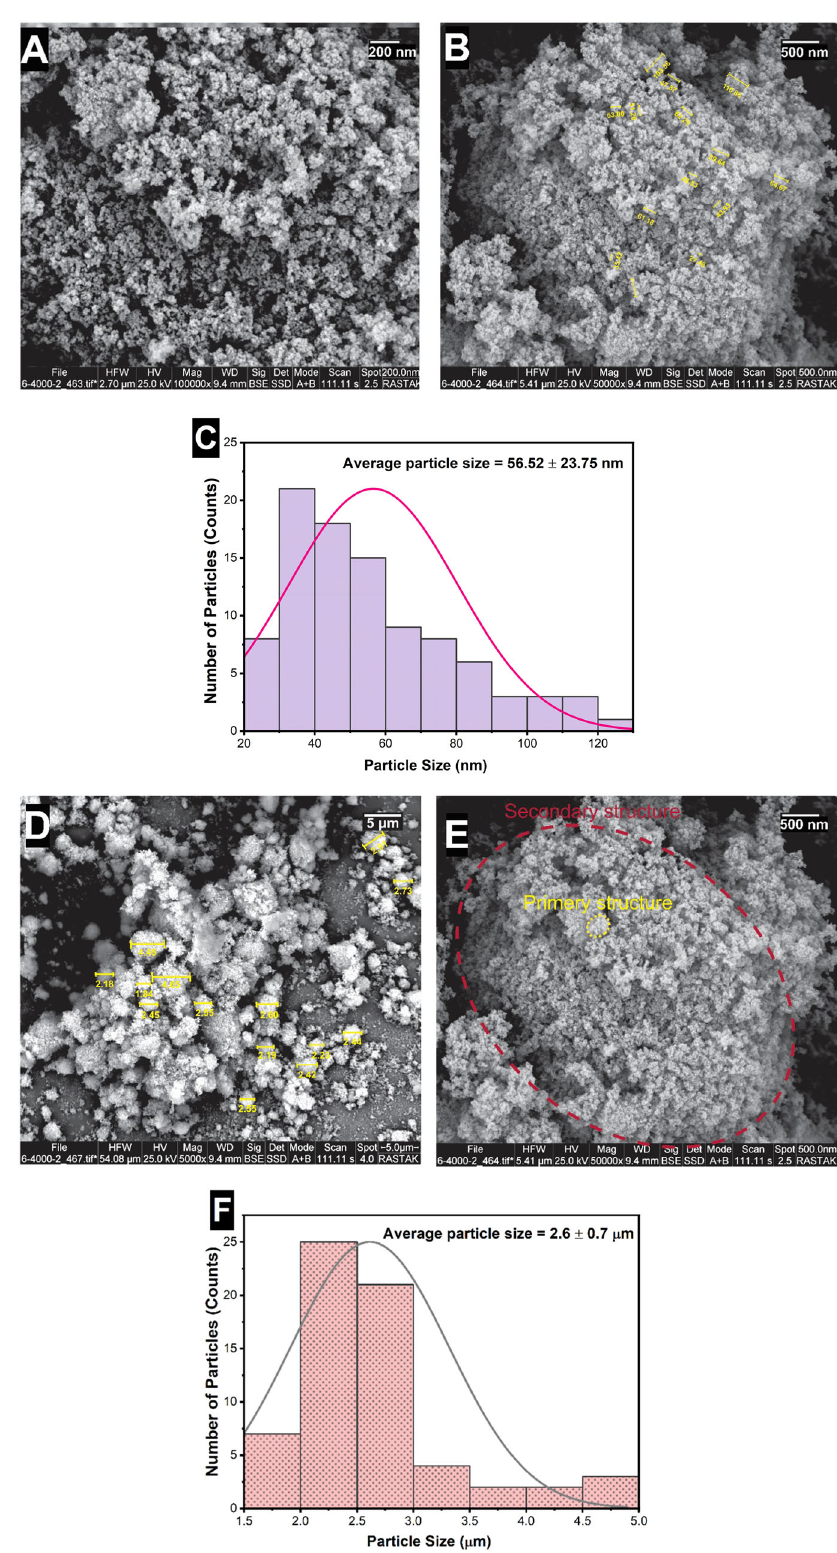
Fig. 2 Morphological characterization and size distribution of TiO 2 NPs. A , B , D , E The FESEM micrographs represented the irregular rock-like architectures, which consist of a secondary structure with particle diameters around a few microns ( E red cycle). And these secondary structures are formed by the agglomeration of the primary structures with particle diameters around a few tens of nanometers ( E yellow cycle). C – F The size distribution of the primary and secondary structures of TiO 2